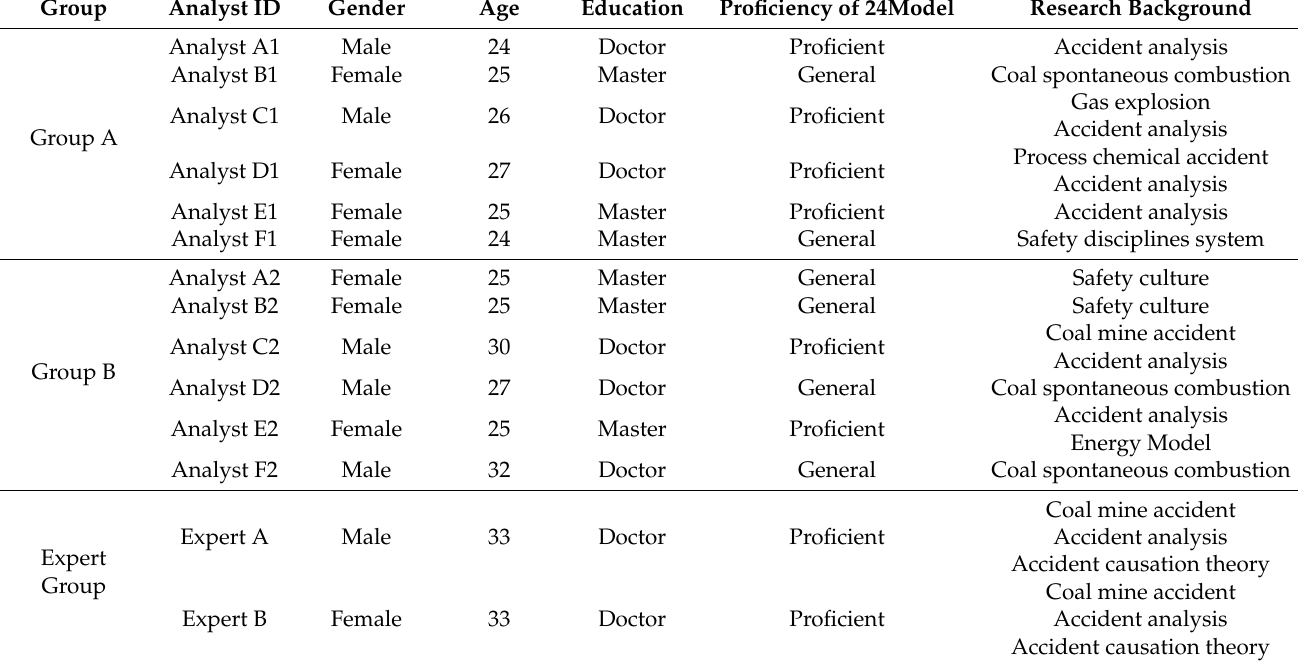
Table 1. Analysis of specific